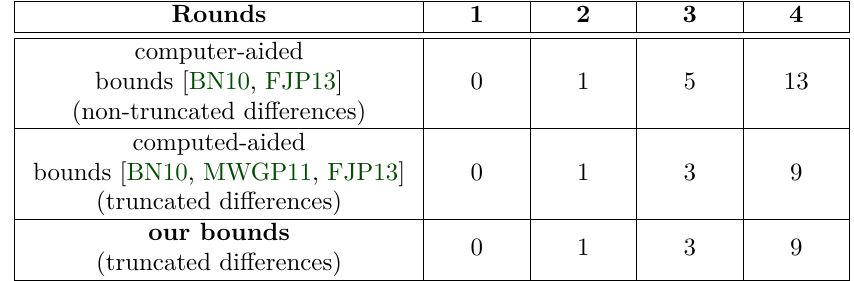
differential propagation of a single active column, in both forward and backward